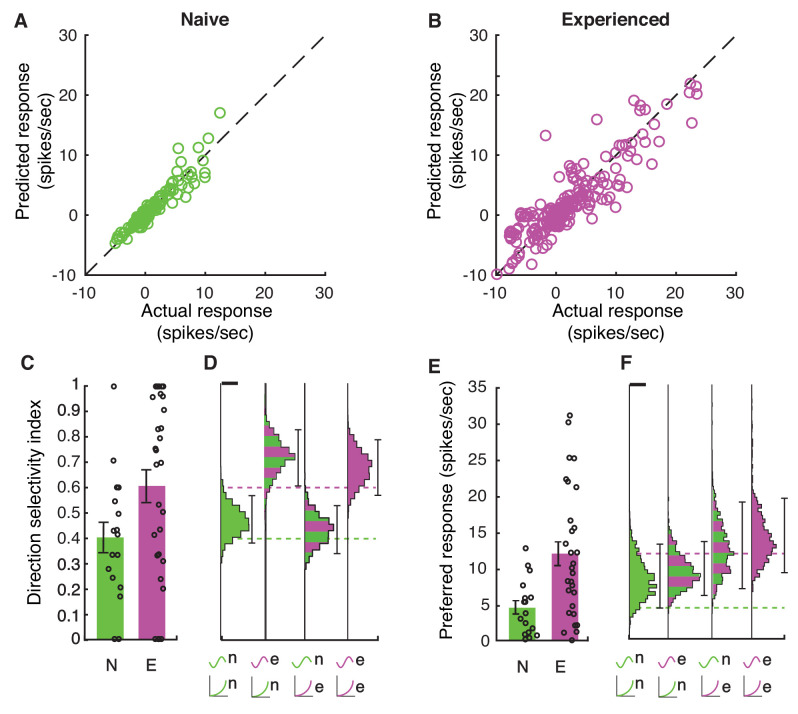
Increases in membrane potential selectivity and input-output gain are both required for mature direction selectivity and firing rates.(A) Actual mean spiking response rates for each stimulus plotted against the mean spiking response that is obtained by applying the voltage-to-firing rate transform to each stimulus’s membrane potential record for all naive cells (N = 16), showing that the phenomenological model captures the voltage-to-membrane transfer well. (B) Same, for experienced cells (N = 29). Model captures the actual spiking responses well. (C) Actual direction index values derived from the mean responses (F0) of naive and experienced cells. (D) Simulations of what we would expect if naive or experienced waveforms were paired with naive or experienced voltage-to-firing rate transforms. Plots show vertical histograms (with 5–95 percentile error bars) of mean direction selectivity index values for 10,000 simulations of 20 cells for several cases: 1) randomly selected naive voltage waveforms applied to randomly selected naive voltage-to-firing rate transforms; 2) randomly selected experienced voltage waveforms applied to randomly selected naive voltage-to-firing rate transforms; 3) randomly selected naive voltage waveforms applied to randomly selected experienced voltage-to-firing rate transforms, and 4) randomly selected experienced voltage waveforms applied to randomly selected experienced voltage-to-firing rate transforms. Scale bar on top of histogram shows 100 simulations. Axis labels identify the model by the waveforms used (top symbol) and voltage-to-firing rate transform used (bottom symbol). Actual data values are shown as dashed lines. To achieve increases in direction selectivity, it was only necessary for the model to adopt the voltage response waveforms of the experienced animals: the increased gain of the experienced animals was not necessary. (E+F) Same as C,D, but response to preferred direction is shown. Scale bar shows 50 simulations. To achieve increases in firing rates observed in experienced animals, experienced voltage-to-firing rate transforms were necessary. In D,F, models can be compared to whether they match the individual cell data by seeing if the individual cell data mean across cells falls within the 5–95%-tile range (the distribution of means is sampled empirically through simulation). Overall, to achieve both increases in direction selectivity and firing rate that are observed in vivo, changes in voltage responses and voltage-to-firing rate transform were necessary.